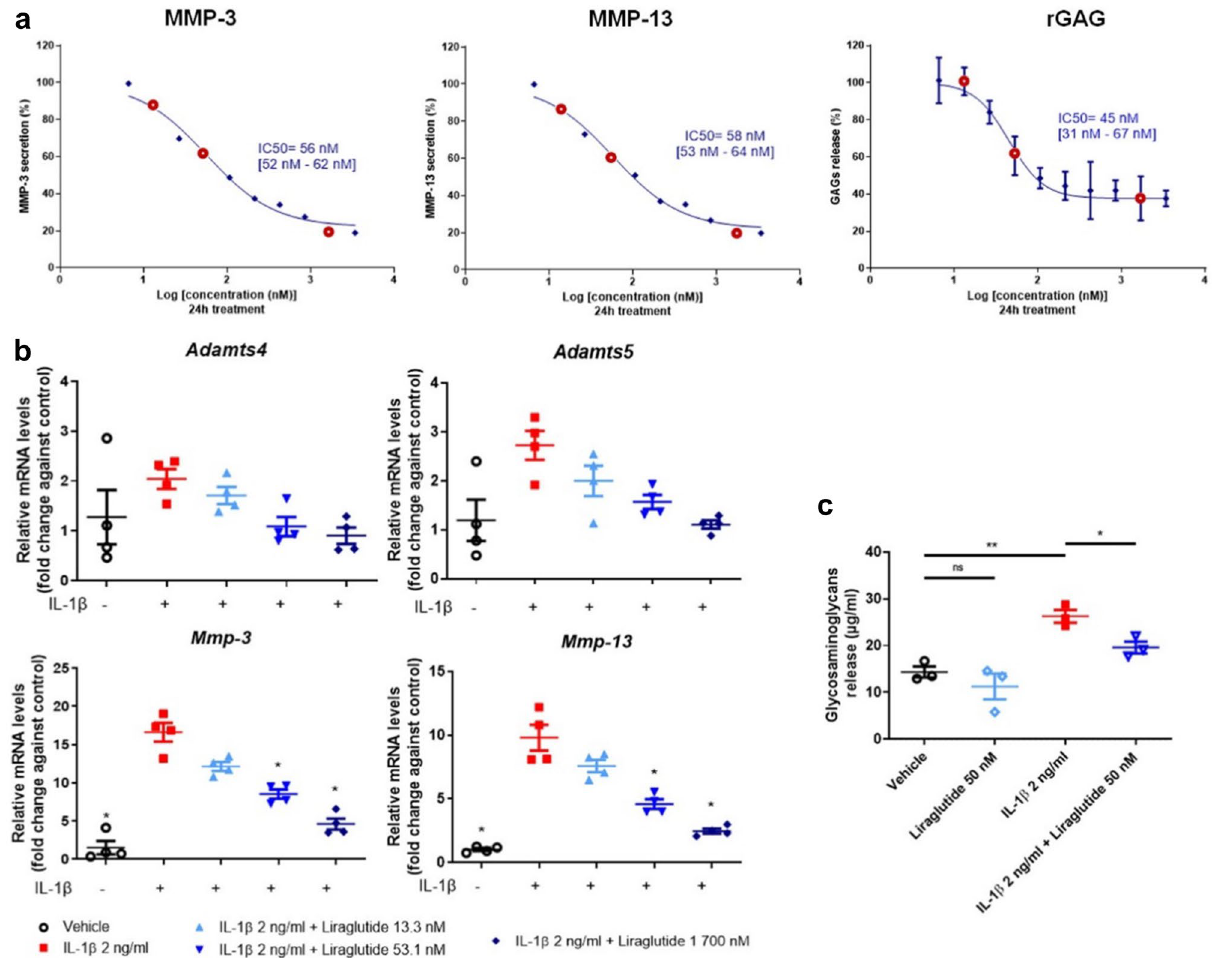
850 nM, 1.7 and 3.4 µM) for 24 h (n = 4). ( a ) The inhibition rate of liraglutide in murine primary chondrocytes was analyzed using GraphPad Prism 9.0 and the IC 50 values were determined. The expression of MMP-3, MMP- 13, and GAG (rGAG) was detected in the cell supernatant. ( b ) Relative mRNA expression of Adamts4 , Adamts5 , Mmp-3 , and Mmp-13 in murine primary chondrocytes co-treated with IL-1β and liraglutide (13.3 nM, 53.1 nM, and 1 700 nM) or vehicle for 24 h (n = 4). ( c ) Murine primary chondrocytes were stimulated with 2 ng/mL of IL-1β and co-treated with 50 nM of liraglutide for 72 h (n = 3). The concentration of glycosaminoglycans